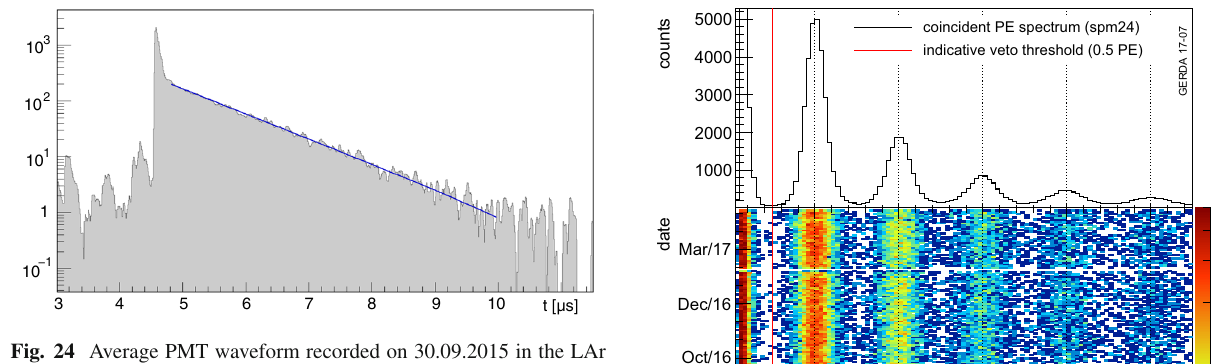
the red lines, that can be easily readjusted if the gain